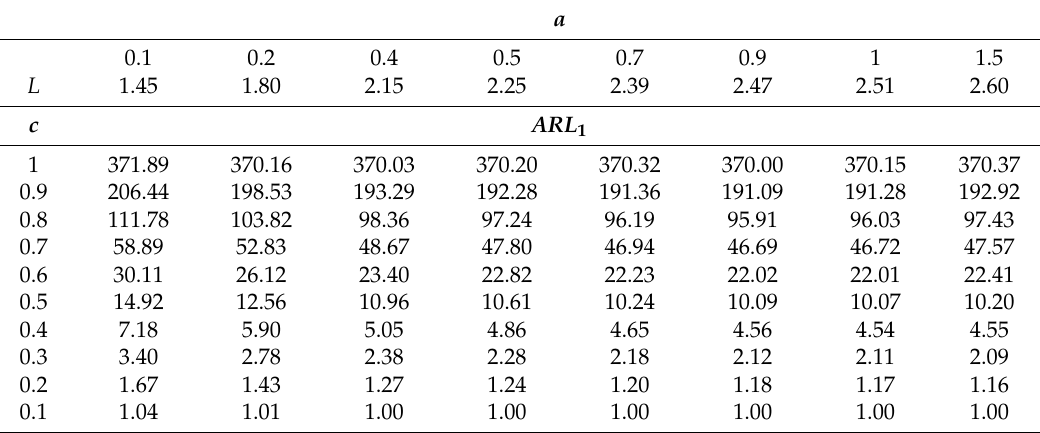
Table 1. The values of ARLs when r 0 = 370, β = 0.5, and µ 0 =